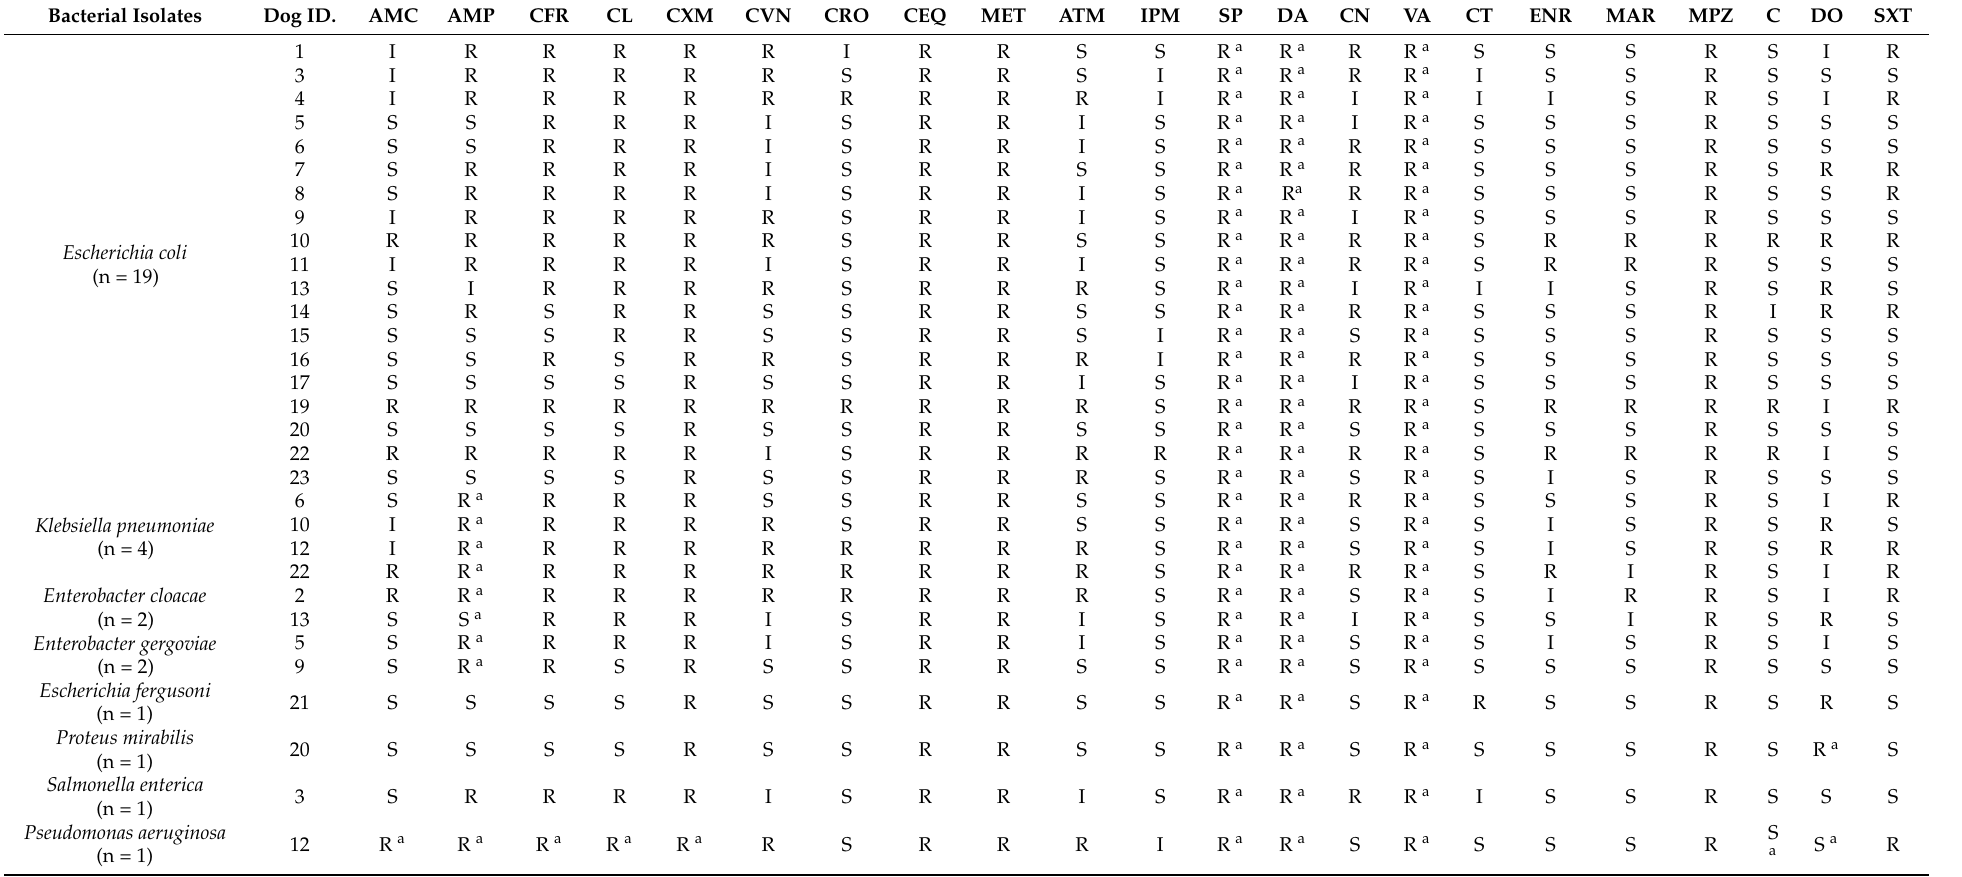
Table 2. Antibiotic sensitivity results derived with the Kirby-Bauer method for the Gram-negative strains (n = 31). Bacterial Isolates Dog